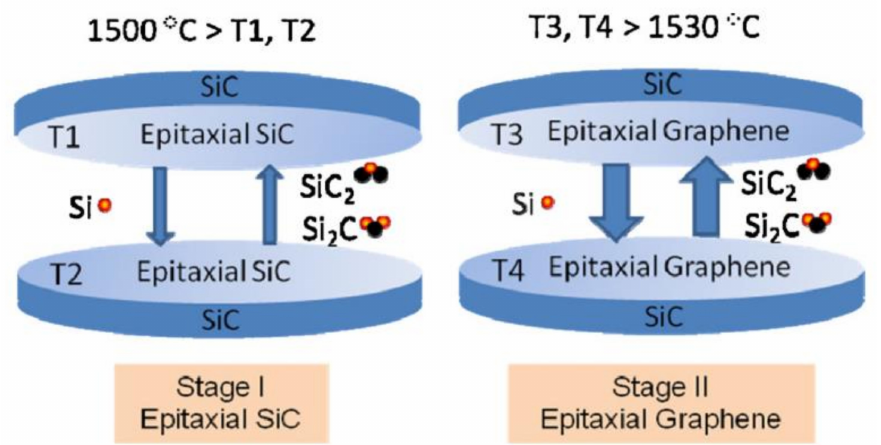
Figure 6. Schematic diagram of the two-step epitaxial graphene growth model. Reproduced from [118] under common